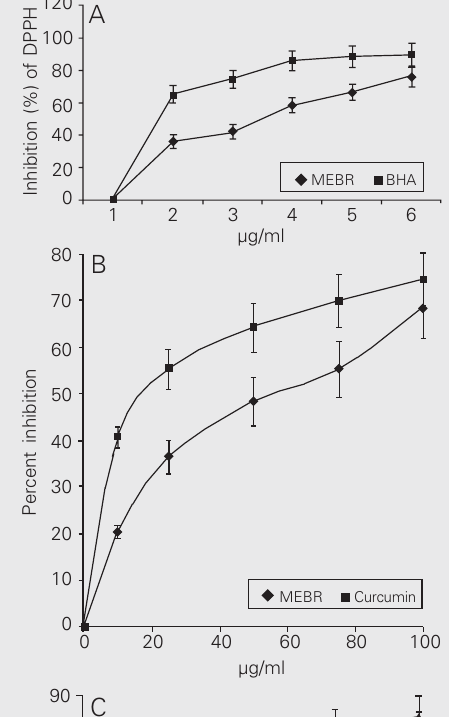
Figure 3. A , Free radical scav- enging activity of a methanol extract of Bauhinia racemosa (MEBR, diamonds) and butyl- ated hydroxy anisole (BHA, squares) by 1,1-diphenyl-2-pic- ryl-hydrazol radicals. B , Inhibi- tion of nitric oxide radicals by MEBR (diamonds) and curcumin (squares). C , Superoxide anion scavenging activity of MEBR (diamonds) and the same doses of quercetin (squares) and butyl- ated hydroxy toluene (BHT, tri- angles). D , Hydroxyl radical scavenging activity of MEBR (diamonds) and catechin (squares) on deoxyribose dam- age. Data are reported as the means ± SD for three measure- ments. P < 0.05 compared to control (% inhibition by control = 0%; ANOVA followed by the Stu- dent t